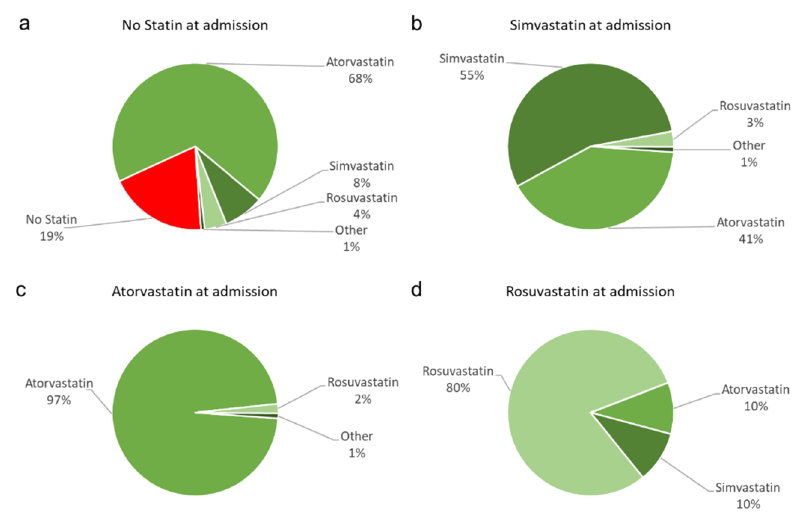
Figure 2. Changes in statin agents, according to initial treatment at admission. ( a ) For patients with no statin prescription at admission, the prescription practices at hospital discharge or after presentation as outpatient in the angiological department of our facility with different statins are displayed in %. Of note, 19% received no statin prescription at discharge (red slice). For patients with ( b ) simvastatin, ( c ) atorvastatin and ( d ) rosuvastatin at admission, the prescription practices at hospital discharge or after presentation as outpatient in the angiological department with different statins are displayed in %. Red color display no statin treatment, green colors display statin treatment (green: atorvastatin, dark green: simvastatin, light green: rosuvastatin, olive: other.